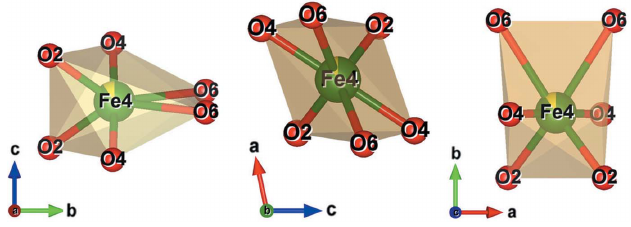
Figure 5 The distorted configuration for M (4) octahedra. The M (4)–O bond distances are: M (4)–O(2) = 2.147 (4) A˚ , M (4)–O(4) = 2.004 (4) A˚ and M (4)–O(6) = 2.66 (4) A˚ . The plots were generated using the VESTA software (Momma & Izumi, 2011).